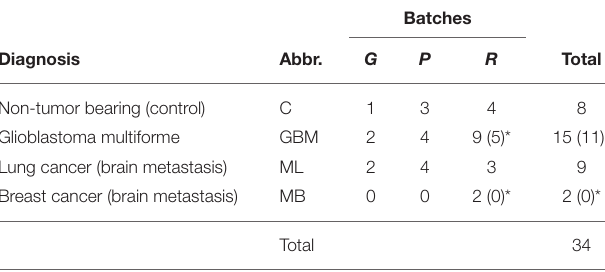
TABLE 3 | Patients tested using the optimized library.